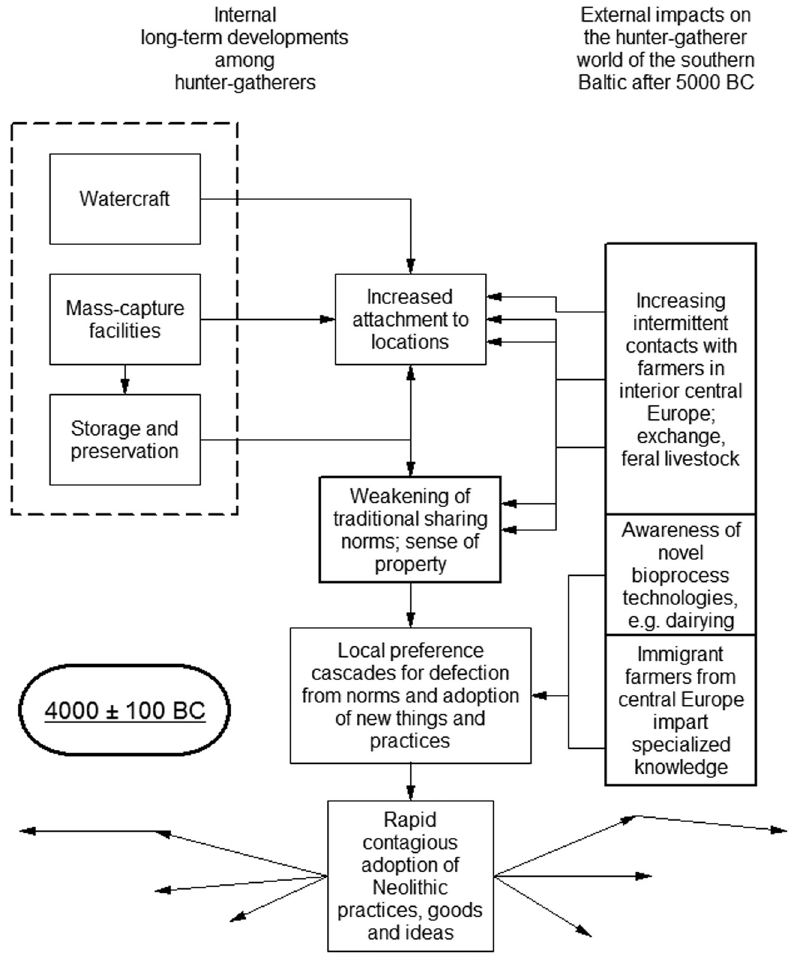
Figure 2: Schematic outline of the argument made in this essay showing relationships among the various processes discussed in the